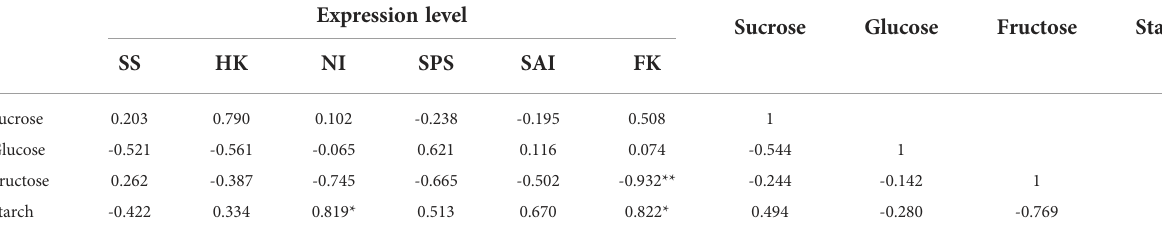
TABLE 2 Correlation coef fi cient between expression of related key genes with sugar and starch content in ‘ Lvmi-1 ’